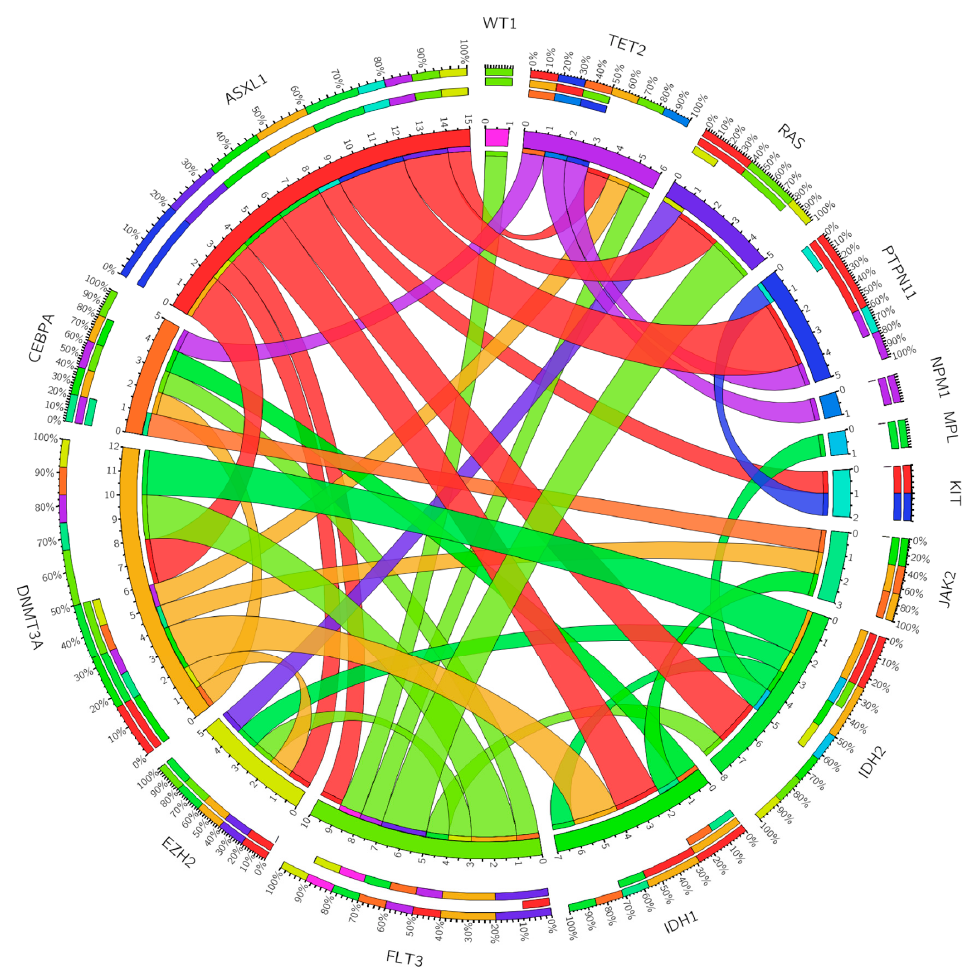
Figure 1. Co-occurring mutations among patients with RUNX1 acute myeloid leukemia. The thickness of the connecting lines indicates the frequency with which the two mutations co-occur.